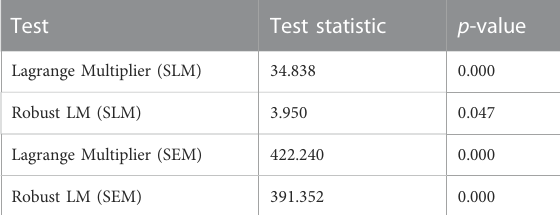
TABLE 3 Model selection test statistical